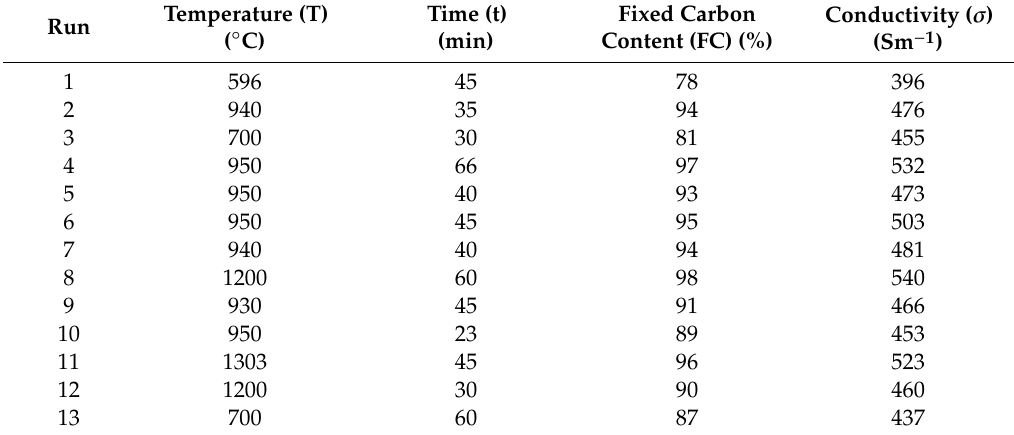
Table 1. E ff ects of time and temperature on fixed carbon content and